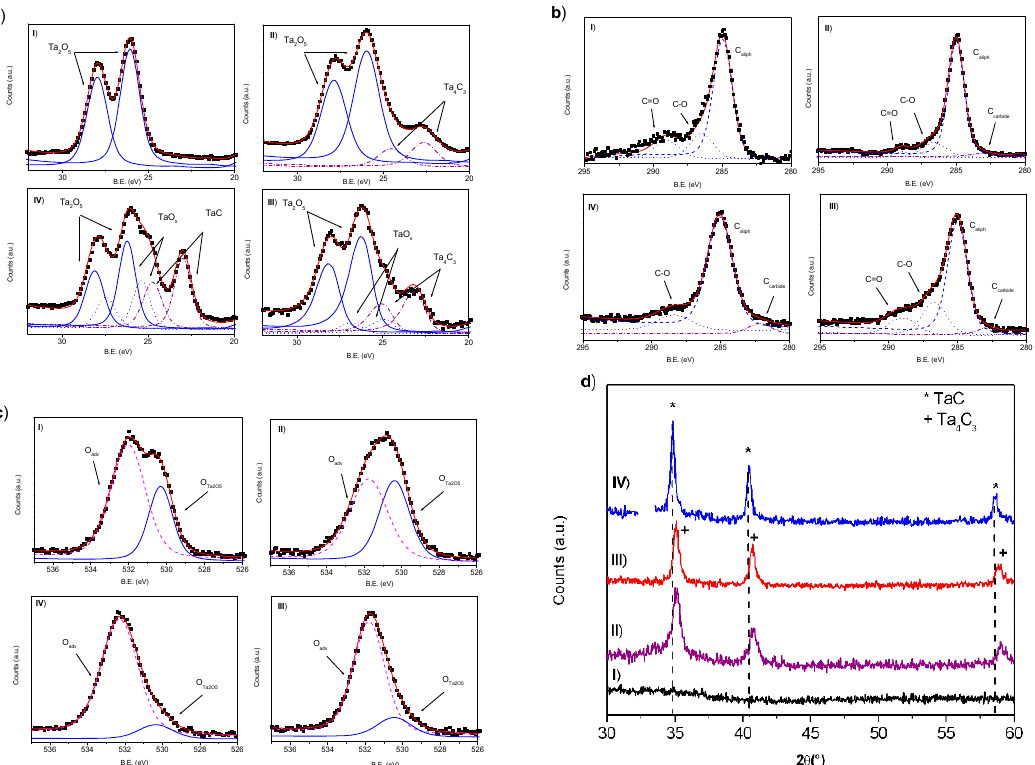
Figure 2. ( a ) XPS Ta 4f region spectra; ( b ) XPS C1s region spectra; ( c ) XPS O1s region spectra and ( d ) XRD spectra of nanoparticles obtained by laser ablation of Ta in water (I), ethanol (II), acetone (III) and toluene (IV). In XPS spectra blue lines are referred to Ta 2 O 5 , blue dotted lines to TaO x and purple dash-dotted lines to Ta x C y species, respectively.